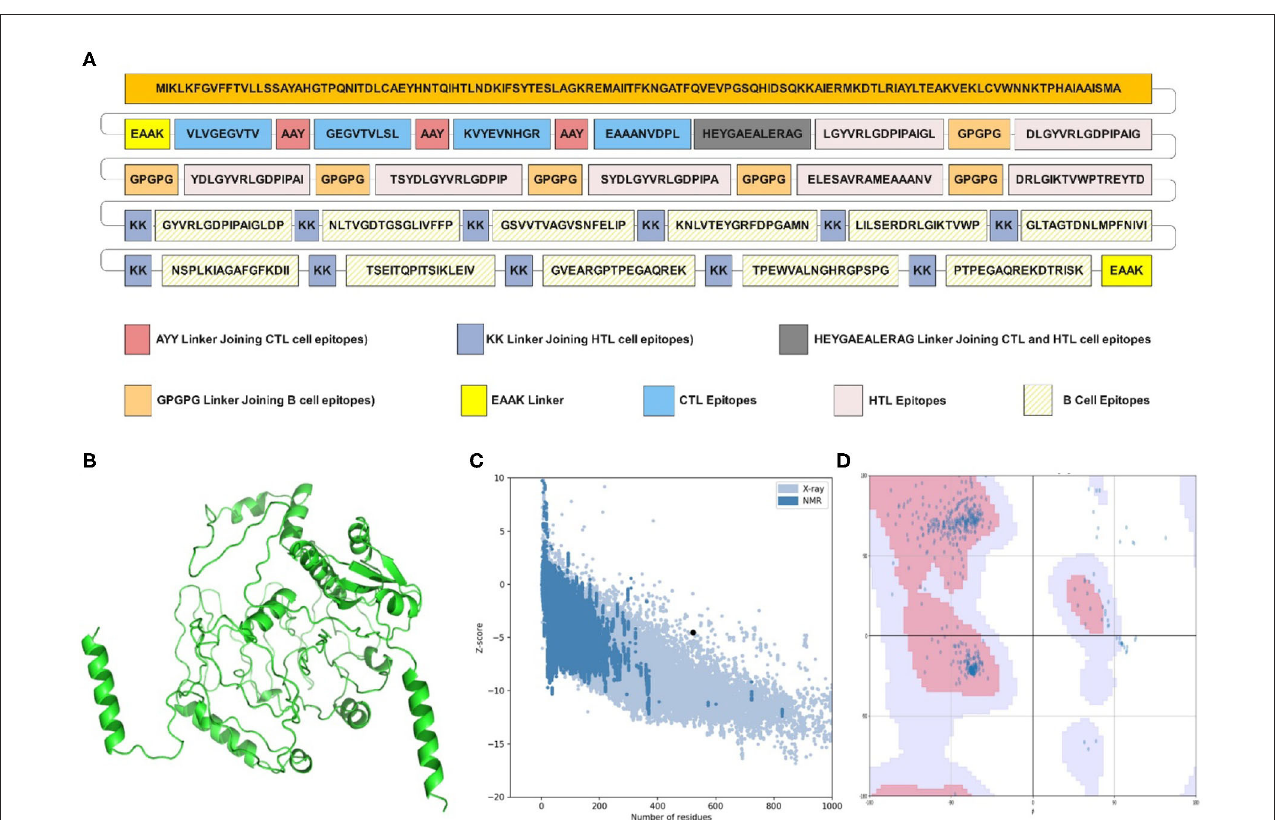
FIGURE1 Structural analysis and validation of designed vaccine. (A) Schematic design of the final vaccine construct. AAY Linkers join the CTL epitopes, HTL epitopes are joined by GPGPG linkers and B-cell epitopes by KK linkers. The Cholera Toxin B (CTB) adjuvant is added to the N-terminus of the sequence by an EAAK linker. An additional EAAK linker C-Terminal and HEYGAEALERAG linkers between CTL and HTL epitopes were incorporated. (B) The refined three-dimensional structure of vaccine construct; (C) ProSA-web assessment of the vaccine tertiary structure. The evaluation revealed a Z -score of − 4.49, indicating good quality. (D) Ramachandran plot analysis of the refined structure. The evaluation revealed that 96.0% of the residues of the vaccine are present in the favored